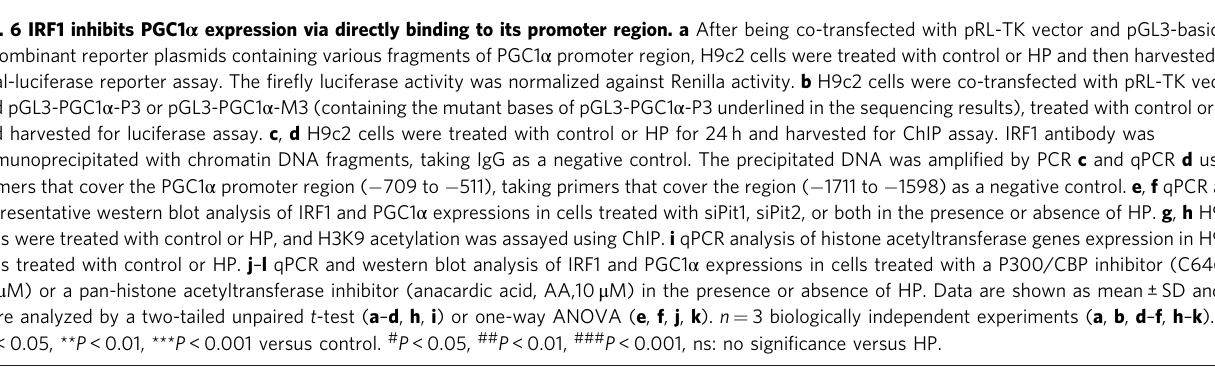
Fig. 6 IRF1 inhibits PGC1 α expression via directly binding to its promoter region. a After being co-transfected with pRL-TK vector and pGL3-basic or recombinant reporter plasmids containing various fragments of PGC1 α promoter region, H9c2 cells were treated with control or HP and then harvested for dual-luciferase reporter assay. The fi re fl y luciferase activity was normalized against Renilla activity. b H9c2 cells were co-transfected with pRL-TK vector and pGL3-PGC1 α -P3 or pGL3-PGC1 α -M3 (containing the mutant bases of pGL3-PGC1 α -P3 underlined in the sequencing results), treated with control or HP and harvested for luciferase assay. c , d H9c2 cells were treated with control or HP for 24 h and harvested for ChIP assay. IRF1 antibody was immunoprecipitated with chromatin DNA fragments, taking IgG as a negative control. The precipitated DNA was ampli fi ed by PCR c and qPCR d using primers that cover the PGC1 α promoter region ( − 709 to − 511), taking primers that cover the region ( − 1711 to − 1598) as a negative control. e , f qPCR and representative western blot analysis of IRF1 and PGC1 α expressions in cells treated with siPit1, siPit2, or both in the presence or absence of HP. g , h H9c2 cells were treated with control or HP, and H3K9 acetylation was assayed using ChIP. i qPCR analysis of histone acetyltransferase genes expression in H9c2 cells treated with control or HP. j – l qPCR and western blot analysis of IRF1 and PGC1 α expressions in cells treated with a P300/CBP inhibitor